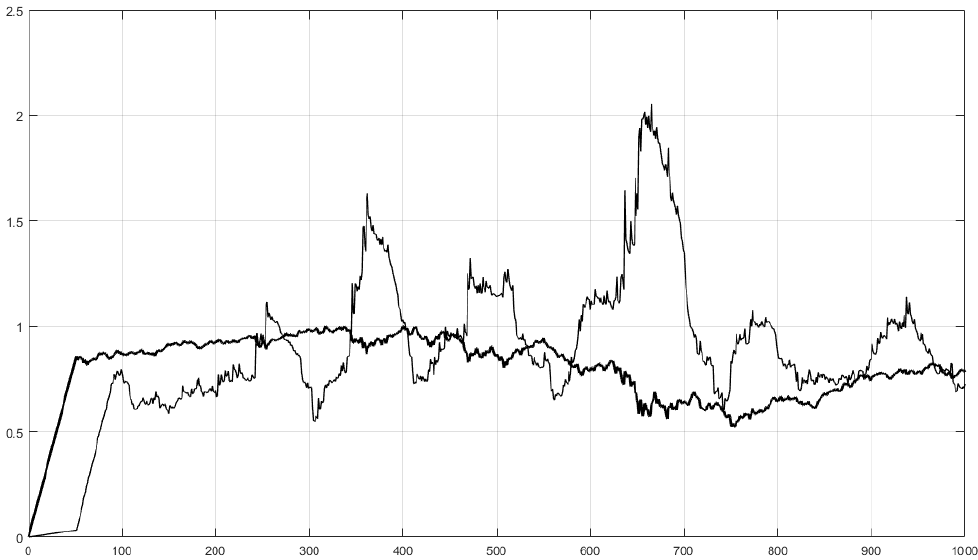
Figure 13. Example of computing the time dependent Lévy index (solid line —) for a normalised financial signal (bold solid line — ) based on the application of Equation (45) using function Levy with a look-back window of 50 data